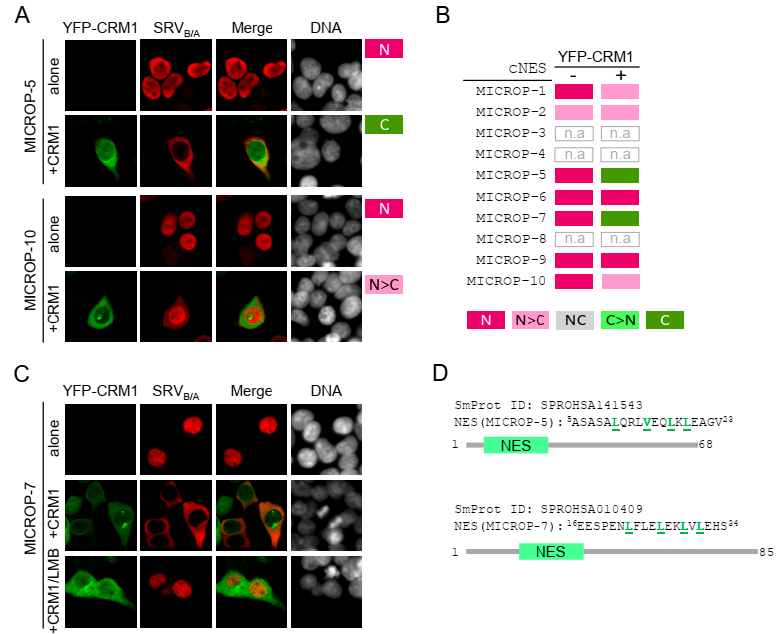
Figure 5. Using the SRV B / A assay to search for NES-harboring micropeptides. ( A ) Fluorescence microscopy images showing representative examples of the localization of SRV B / A reporters containing two di ff erent cNES motifs (MICROP-5 and MICROP-10, see Supplementary Table S3), when transfected alone or co-transfected with YFP-CRM1 wild-type ( + CRM1) into HEK293T cells. The DNA-staining dye DAPI was used to visualize the nuclei. As indicated to the right of the images, using assessment method 1 the localization of SRV-MICROP-5 was classified as N (alone) and C ( + CRM1), while the localization of SRV-MICROP-10 reporter was classified as N (alone) and N > C ( + CRM1). ( B ) Summary of the localization of SRV B / A reporters containing candidate NES motifs. The cNES ID (Supplementary Table S3) for each motif are indicated to the left. The localization of each reporter expressed alone ( − ) or co-expressed with YFP-CRM1 wild-type ( + ) was assessed using method 1. Except SRV-MICROP-2, which showed a faint cytoplasmic signal (N > C localization), all reporters showed exclusively nuclear (N) localization when expressed alone. When co-expressed with YFP-CRM1, the localization of SRV-MICROP-2, SRV-MICROP-6 and SRV-MICROP-9 reporters remained invariable, SRV-MICROP-1 and SRV-MICROP-10 partially relocated to the cytoplasm and SRV-MICROP-5 and SRV-MICROP-7 fully relocated to the cytoplasm. n.a.: not assayed. ( C ) Fluorescence microscopy images showing that LMB treatment blocks the cytoplasmic relocation of SRV-MICROP-7 induced by co-expression with YFP-CRM1. ( D ). Schematic representation of human micropeptides SPROHSA141543 and SPROHSA010409 (SmProt IDs), showing the position of the novel NESs identified. The amino acid sequence of the NES motifs is indicated, with the hydrophobic residues that conform to the NES consensus highlighted in green.